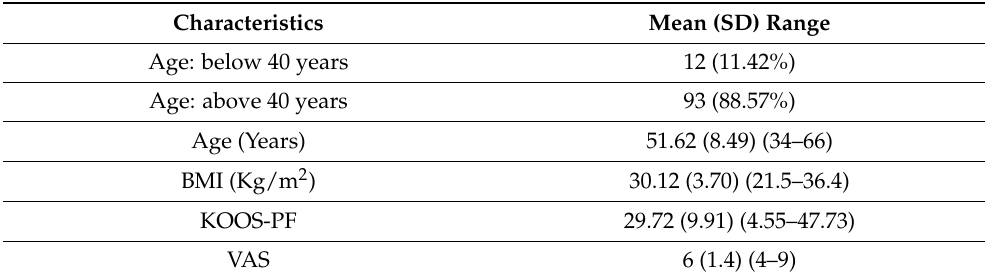
Table 1. Baseline characteristics of female patients with patellofemoral pain ( n = 105).